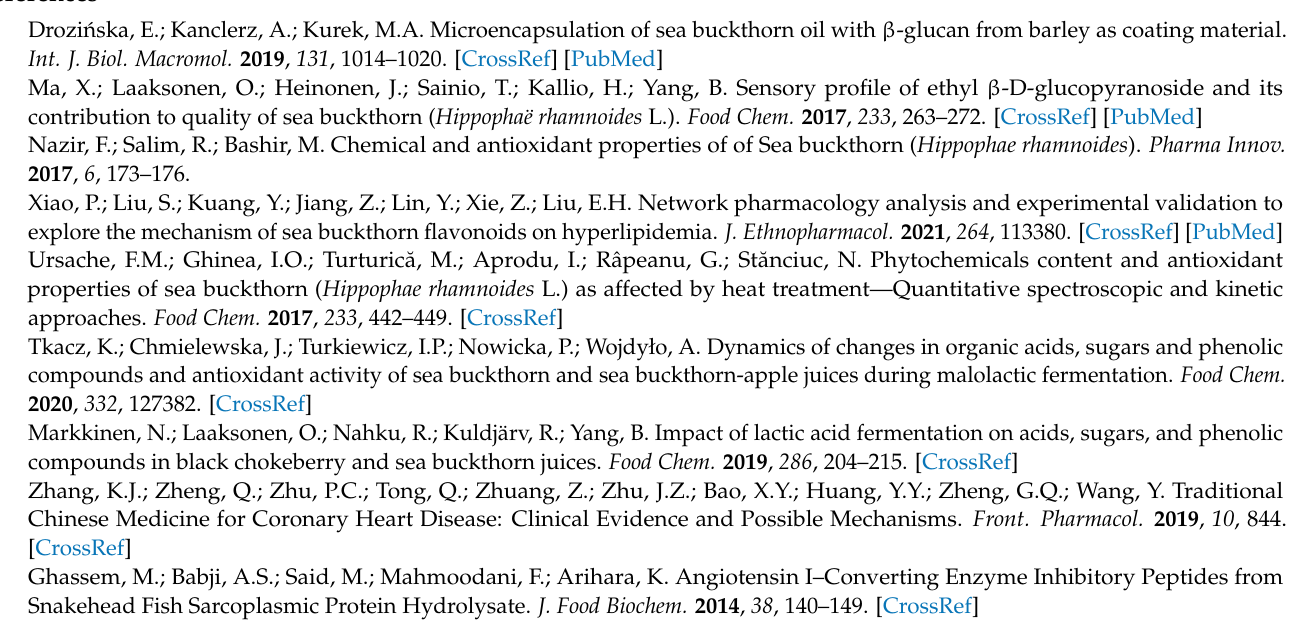
Table S2: experimental design and results of central composite design for optimization of pro-biotic growth in sea buckthorn